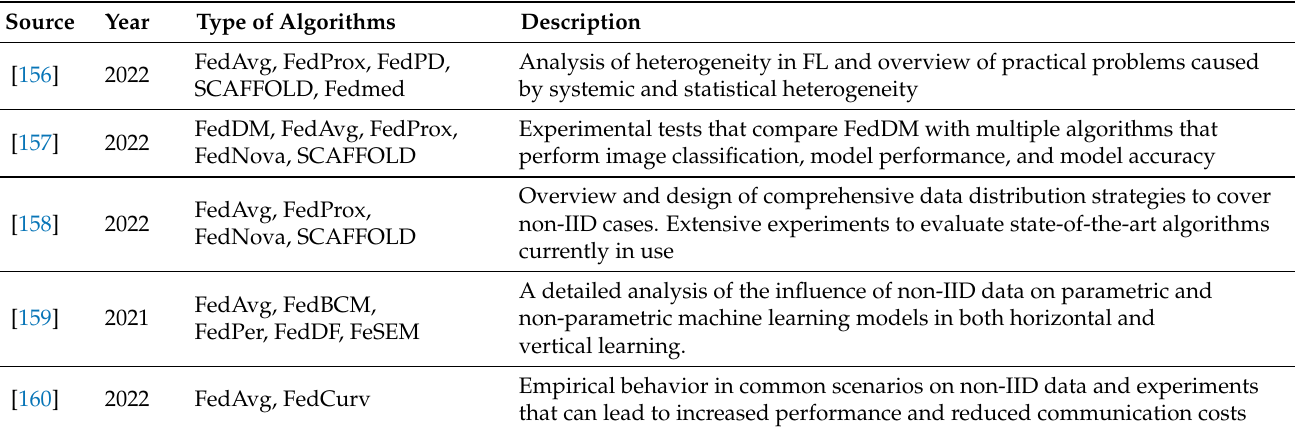
Table 6. Algorithms